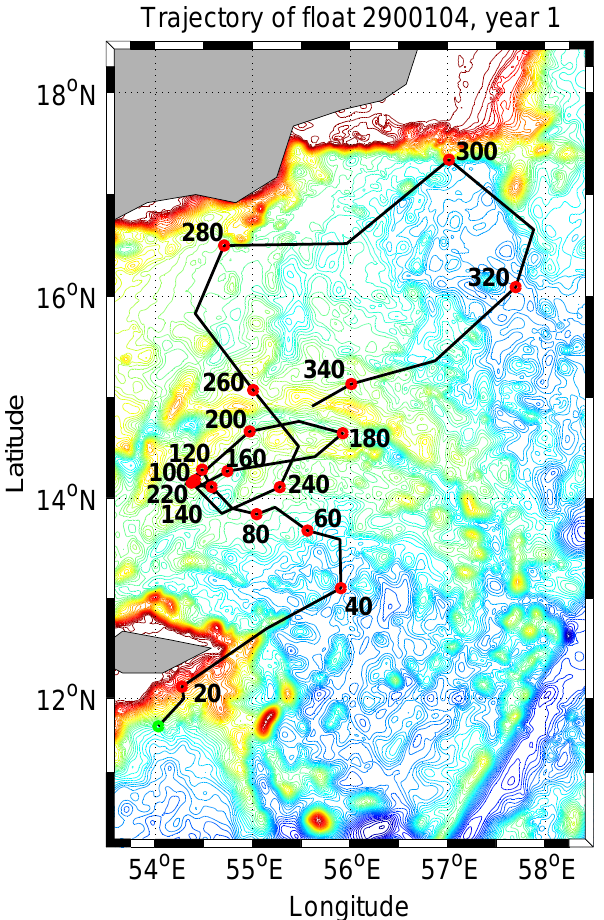
Fig. 13. Trajectory of float 2900104 in the Arabian Sea, superim- posed on bathymetry, year 1; the black dot is the starting point of Figure 13: Trajectory of float 2900104 in the Arabian Sea, superimposed on bathymetry, the trajectory; positions every 20 days are indicated by a red year 1; the black dot is the starting point of the trajectory; positions every 20 days are indicated by a red dot.